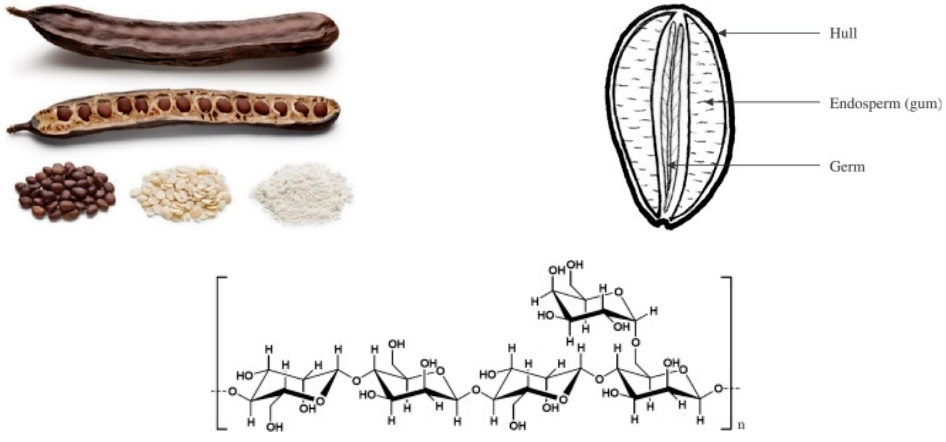
Figure 1. Carob fruit and locust bean